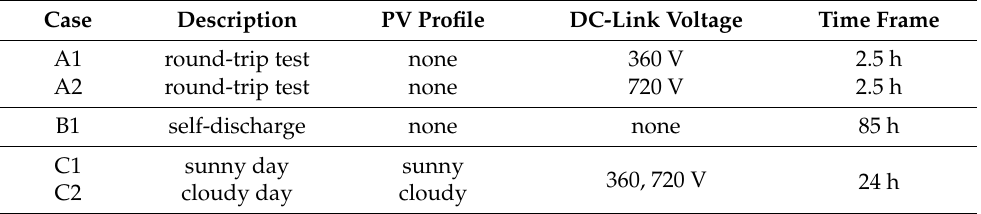
Table 3. Simulation case